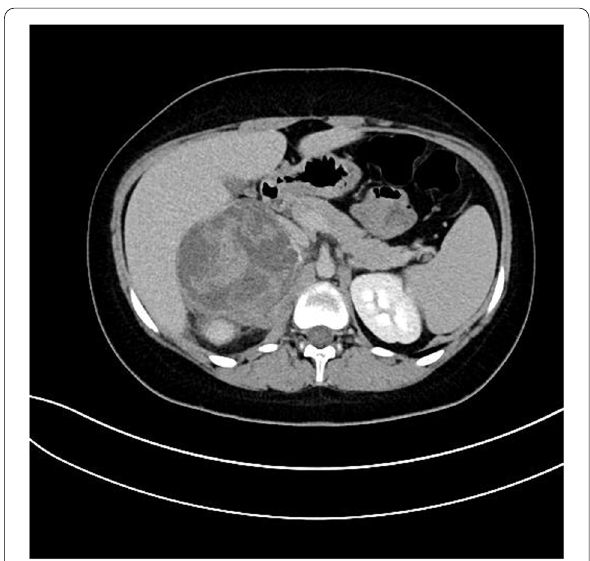
Fig. 1 Contrast-enhanced computed tomography (CT), venous phase, axial